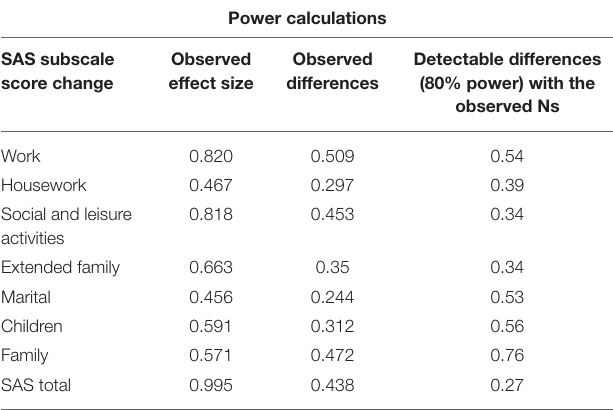
TABLE 5 | Power calculations for SAS total and subscales—IPSRT compared with